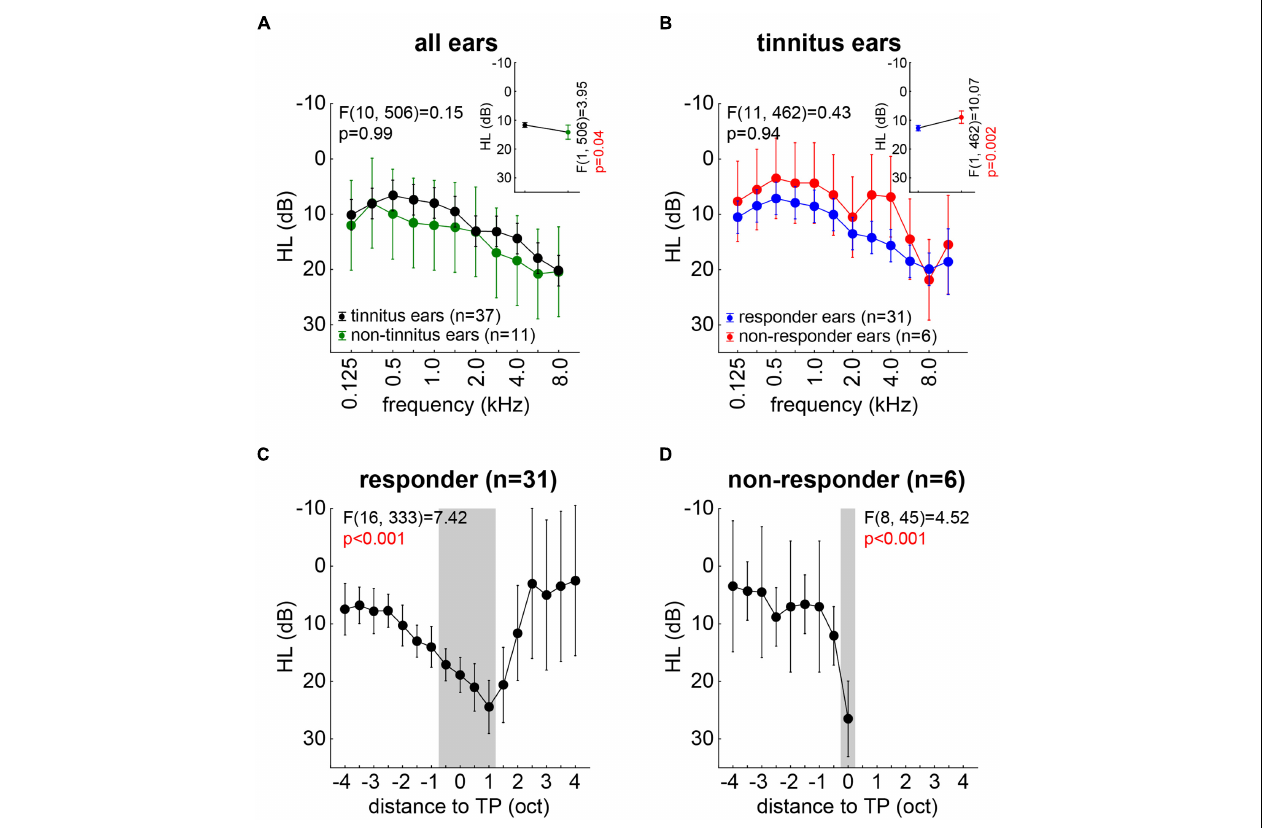
FIGURE 3 | Overview of hearing loss (dB) for all measured ears with F statistics. (A) Interaction plot of the two-factorial ANOVA of HL for tinnitus and non-tinnitus ears across all frequencies. The inset depicts the mean HL across all frequencies for both ear types. (B) Interaction plot of the two-factorial ANOVA of HL for tinnitus ears only in responders and non-responders. The inset depicts the mean HL for both patient groups. (C) One-factorial ANOVA of HL of all responders’ ears aligned on the individual TP. Gray area indicates significant HL revealed by Tukey post hoc tests. (D) One-factorial ANOVA of HL of all non-responders’ ears aligned on the individual TP. Gray area indicates significant HL revealed by Tukey post hoc tests.